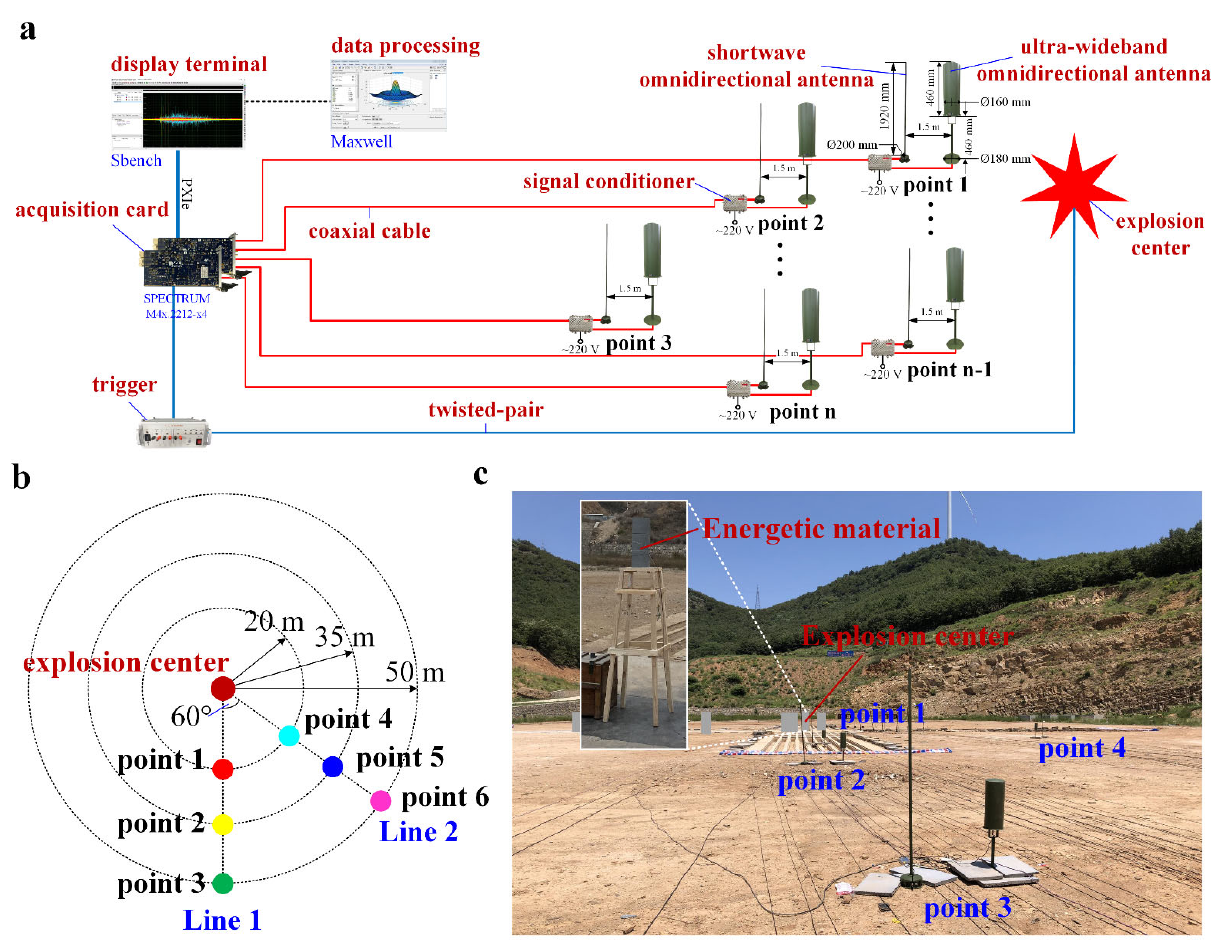
Figure 1. ( a ) electromagnetic radiation experimental device; ( b ) test points distribution; ( c ) experi ‐ ment field.